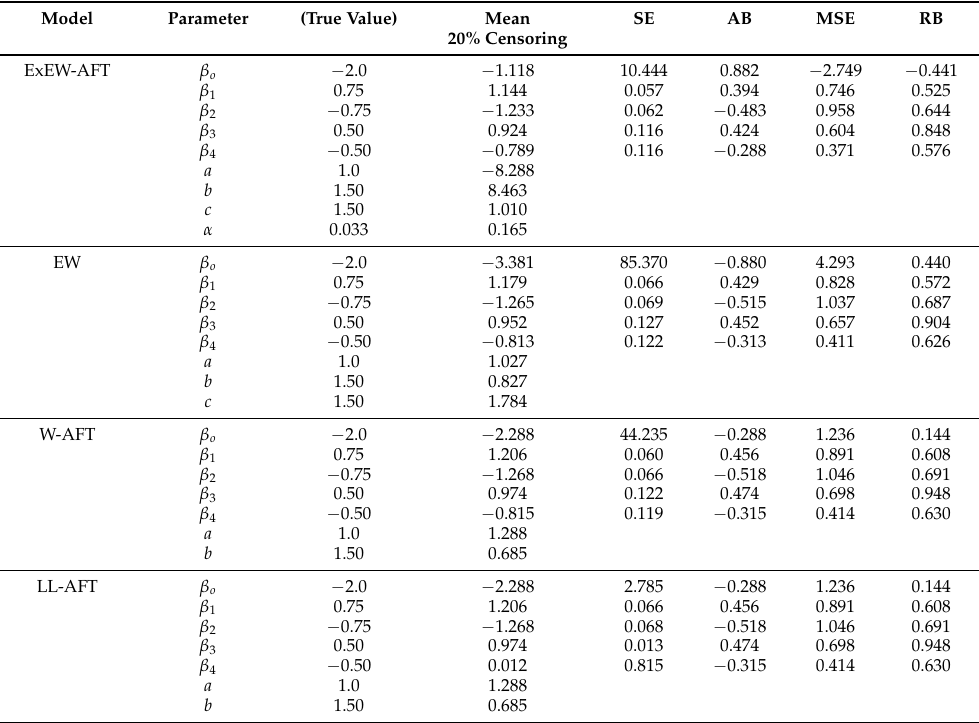
Table 1. Simulation study for scenario 1 ( n = 1000) with about 20% censored observations is used to compare model performance.